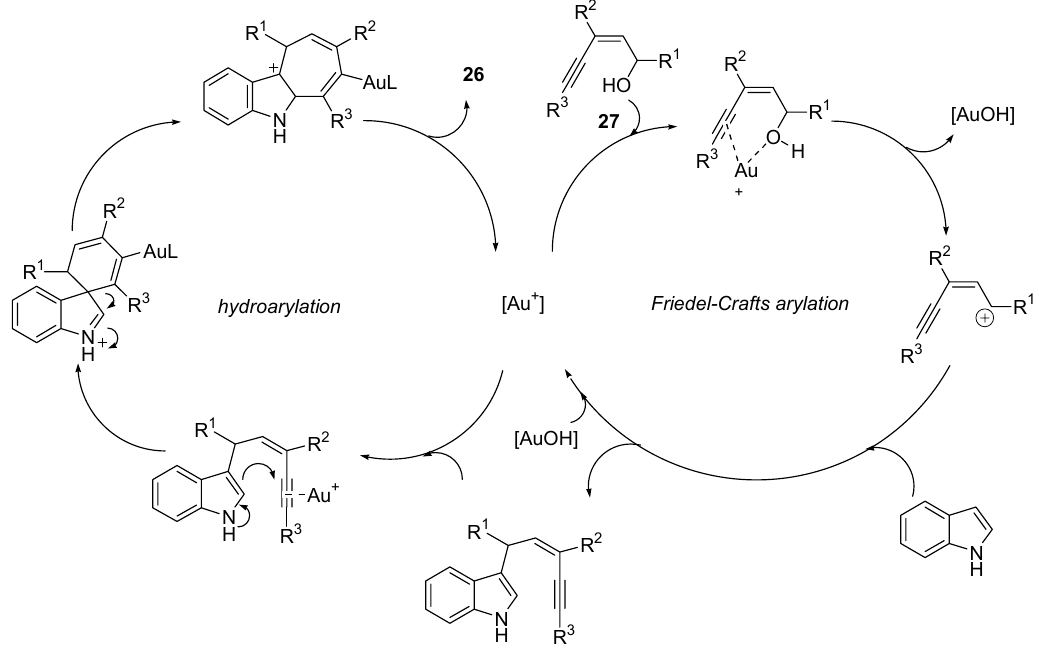
Scheme 9. Proposed reaction mechanism for the tandem gold catalyzed-Friedel-Crafts arylation/hydroarylation process.